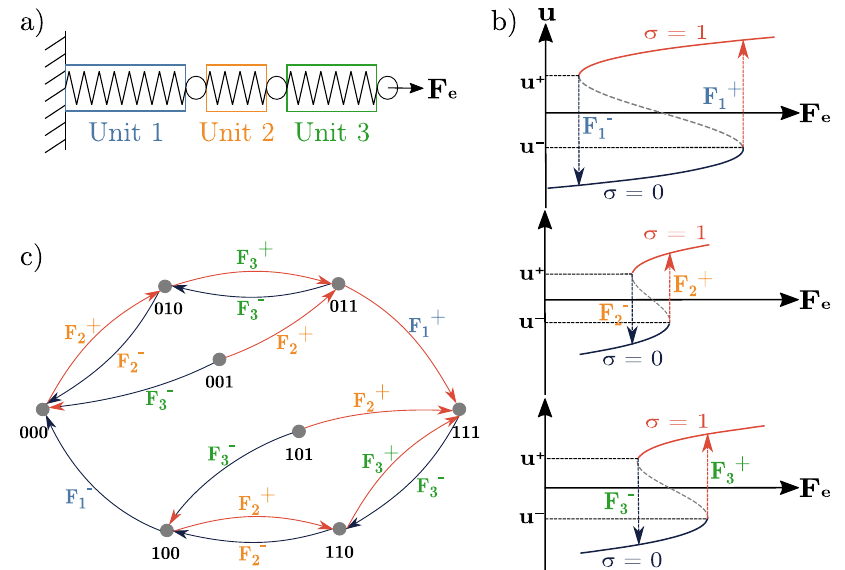
Fig. 1 Model for a chain of three coupled bi-stable spring-mass units. a Schematics view of the model. Each unit, characterized by a color, corresponds to a bistable spring while each circle corresponds to a mass. The fi rst unit is attached to a fi xed wall and an external force F e is applied to the last mass. b Deformation u of each unit under external load F e (see “ Methods ” for more details on the springs' parameters). The switching fi elds F ± i are de fi ned through Eq. (4). c Transition graph where the nodes represent the stable con fi gurations and the arrows the quasi-statically achievable transitions between them. The states 001 and 101 are unreachable “ Garden of Eden ” states with this choice of